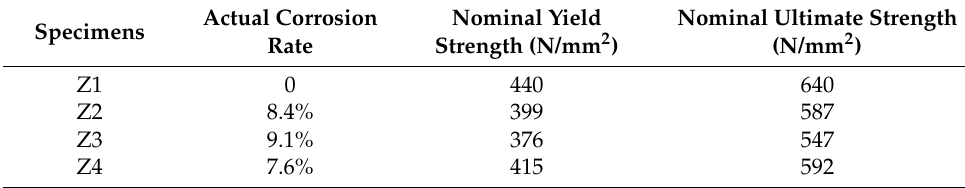
Table 2. Material properties of main reinforcement.